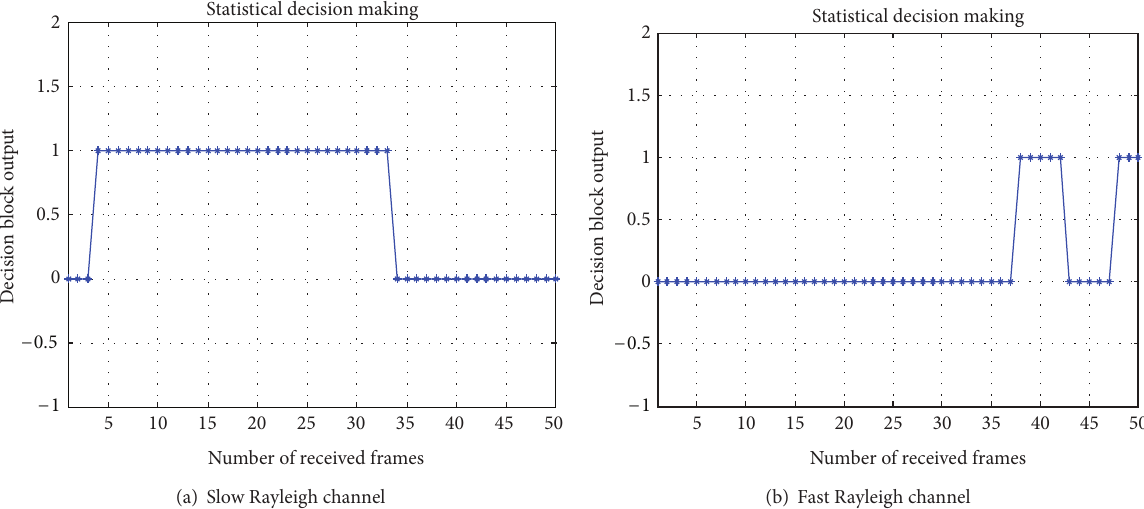
F 12: Decision-making results for the rayleigh channel; “1”